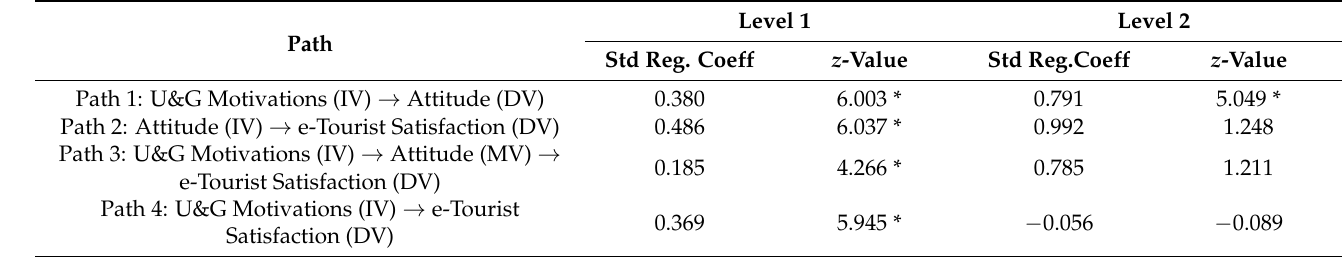
Table 5. Results from the Regression and Mediation Analyses for the Level 1 and Level 2 Model. Level 1 Level 2 Path Std Reg. Coeff z -Value Std Reg.Coeff z -Value